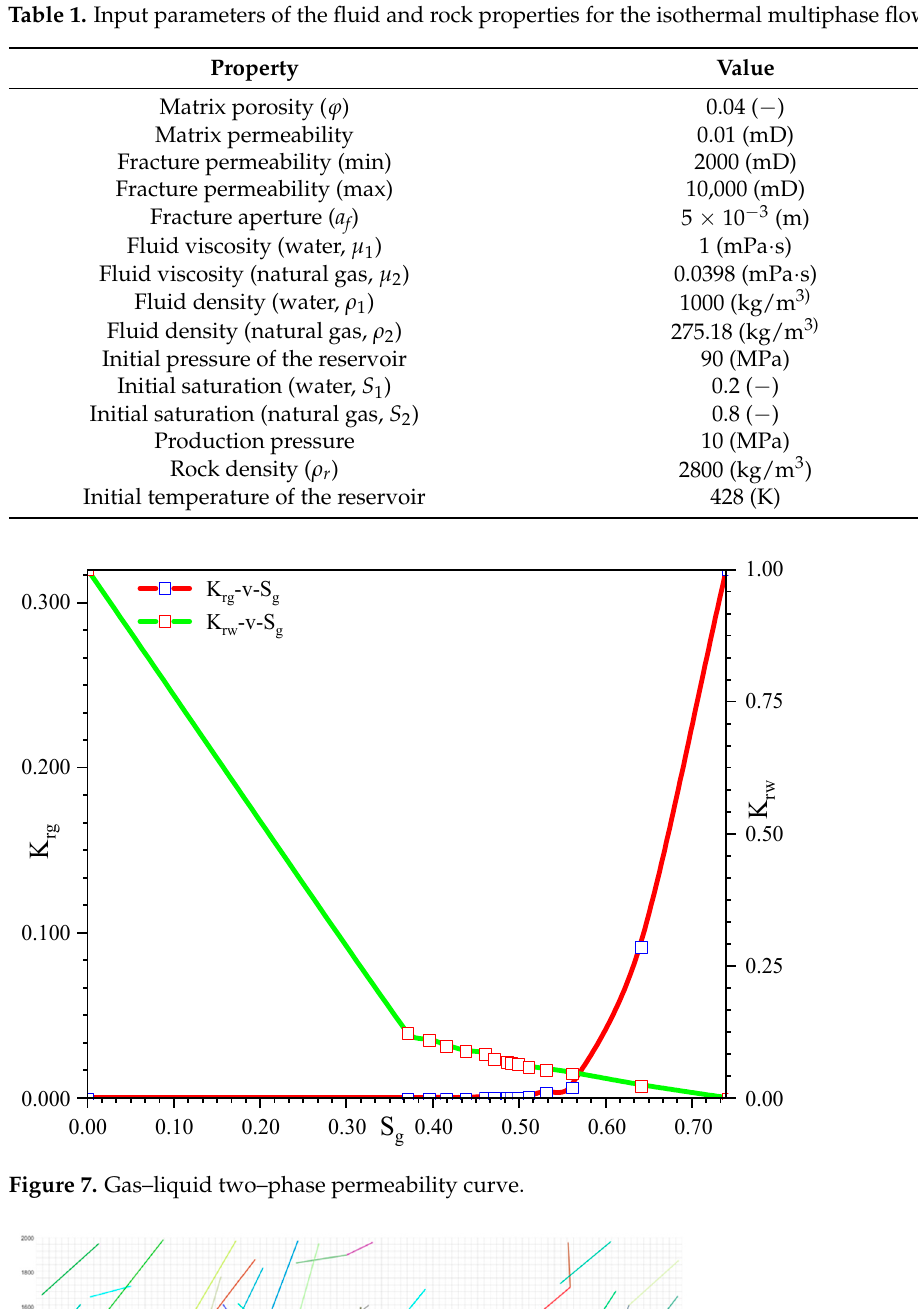
Table 1. Input parameters of the fluid and rock properties for the isothermal multiphase flow.